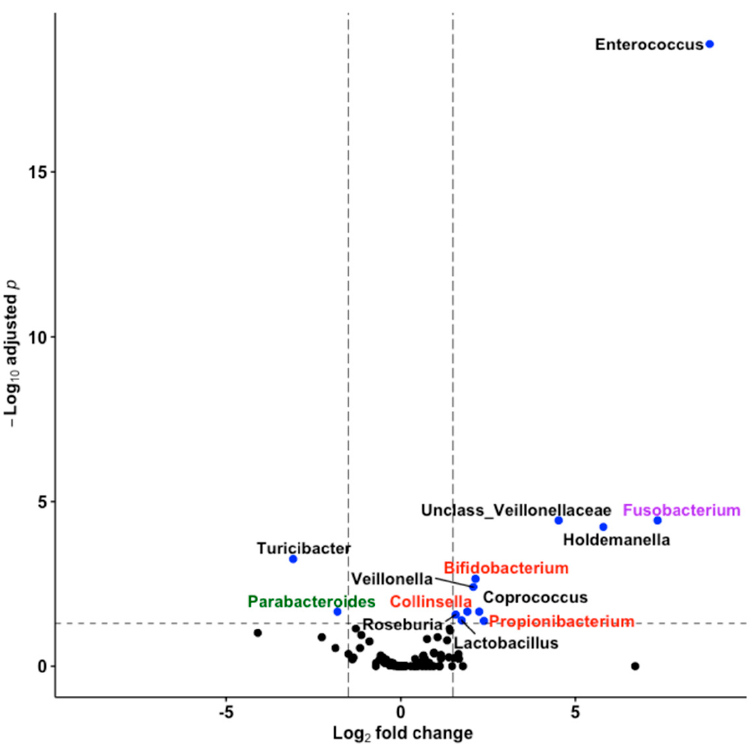
Figure 3. Differential abundance of gut microbiota between infants with above- and below-median fine motricity groups. Volcano plot showing shrunken log 2 fold changes in mean abundance of genera versus − log 10 of FDR. Blue colours depict significance and label names denote the taxonomy of genera at phylum level: Firmicutes (black), Actinobacteria (red), Bacteroidetes (green), Fusobacteria (purple). Dashed lines denote thresholds of significance (FDR < 0.05).